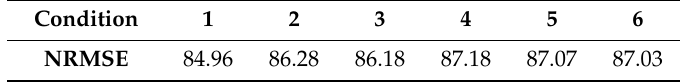
Table 6. The accuracy of the MPC simulation is measured using NRMSE and multiplied by 100 to be expressed as a percentage, with 100 being a perfect fit. The accuracy of the MPC simulation is represented for the difference in input (accumulated replaced medium (mL)) of the experimental data compared to the input of the simulated data. All NRMSE values calculated for all three donors and all three triplicates are equal for the same condition of medium replacement.